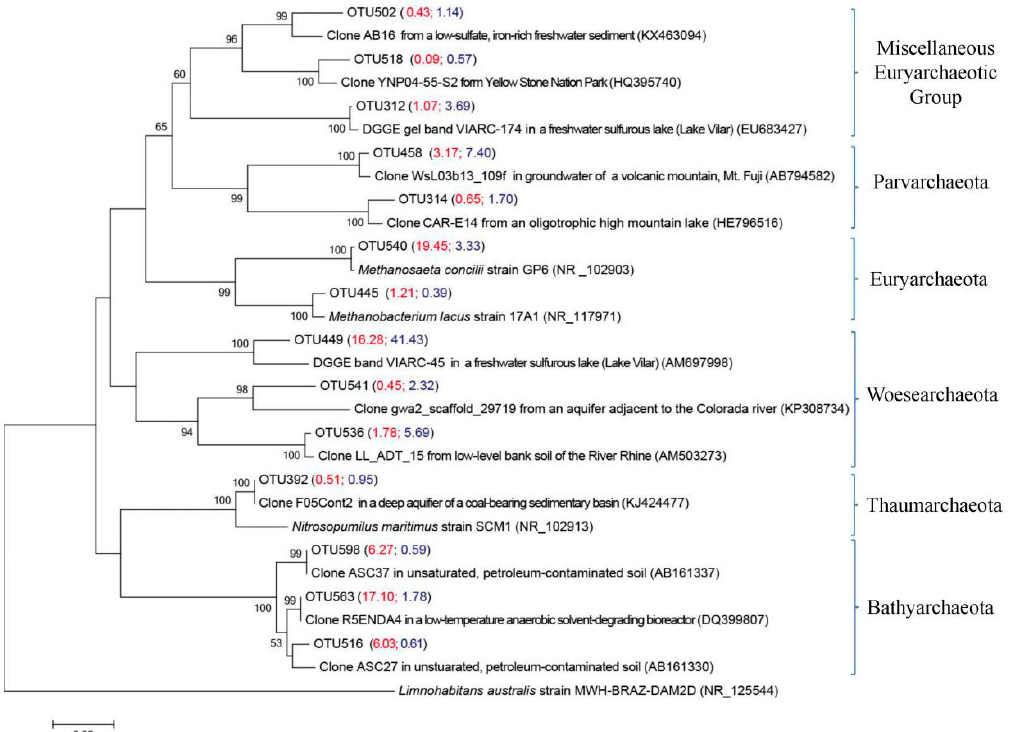
Figure 5. Neighbor-joining phylogenetic tree based on 16S rRNA gene sequences showing the phylogenetic relationship among the representative archaeal OTUs obtained in the > 0.45 µ m size fraction and the 0.2–0.45 µ m fraction and reference 16S rRNA gene sequences retrieved from the NCBI GenBank. These archaeal OTUs were represented by the top 10 reads from the > 0.45 µ m size fraction and the 0.2–0.45 µ m fraction. The scale bar represents the estimated number of nucleotide changes per sequence position. Percentage numbers on nodes refer to 1000 bootstrap resamplings conducted. Only values > 50% are shown. Bold archaeal OTUs were obtained from the > 0.45 µ m size fraction and the 0.2–0.45 µ m fraction. The numbers in parentheses indicate the percentage composition of reads in each sample in the following order: (AP, AF). Limnohabitans australis strain MWH-BRAZ-DAM2D (NR_125544) was used as the outgroup. The number in parentheses represents the mean value of quadruplicate analyses.